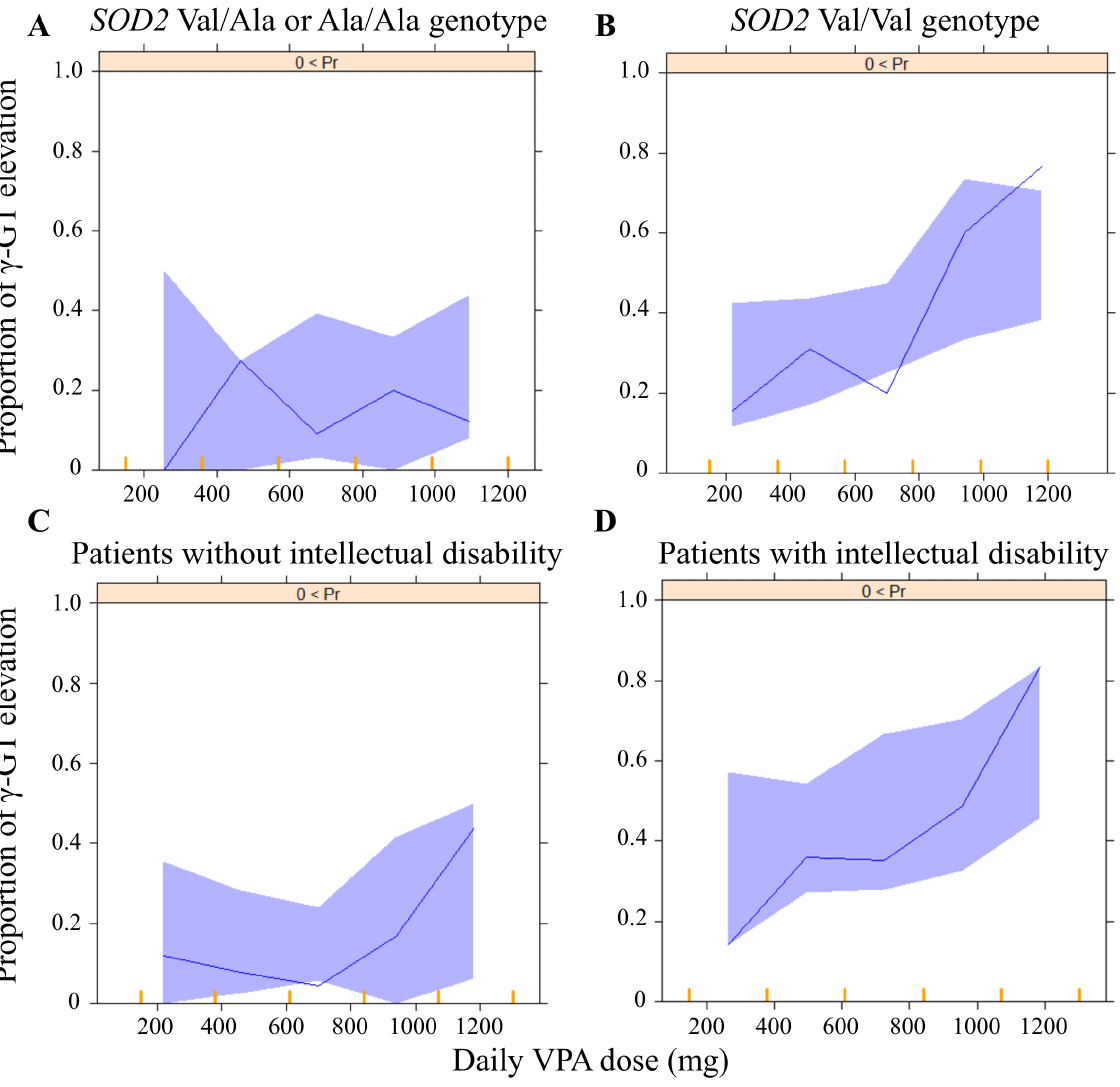
Figure 1. The visual predictive check of the PK-PD model in patients with the SOD2 Ala/Ala or Val/Ala genotype (A), those with SOD2 Val/Val genotype (B), those without intellectual disability (C) and those with intellectual disability (D), using the dataset of the study patients aged 30 years old or younger who were treated with 100 to 1,300 mg/day of VPA. The solid line represents the observed proportion of c -GT elevation and the solid area represents the 90% prediction interval. PK=pharmacokinetic; PD=pharmacodynamics; SOD2=superoxide dismutase 2; VPA=valproic acid c -GT: c -glutamyltransferase.